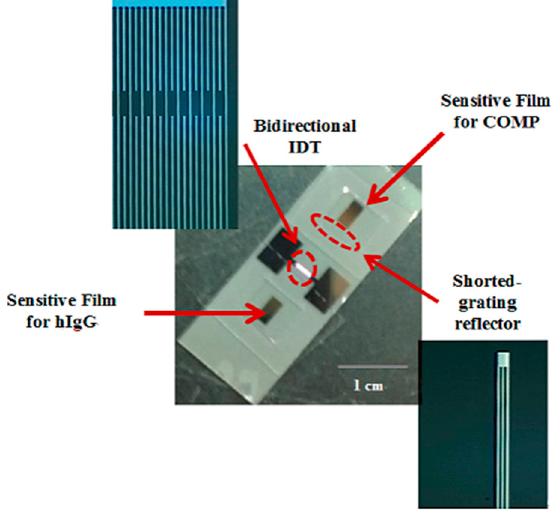
Figure 6. Fabricated one-port Love wave delay line with PMMA overlayer and two sensitive